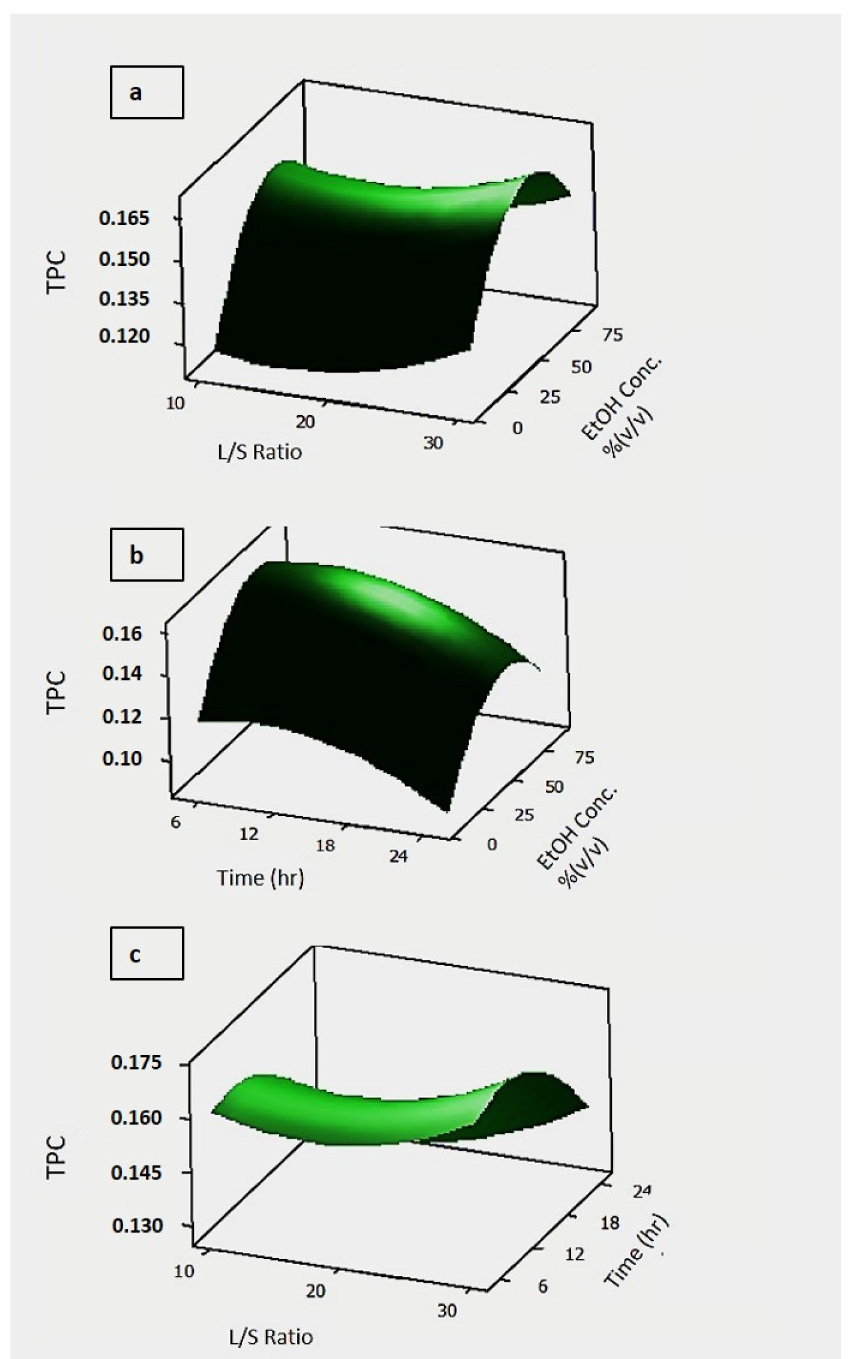
Figure 8. Effect of process parameters on the total phenol content. In the figure, ( a ) total phenolic content vs EtOH concentration and L/S Ratio; ( b ) total phenolic content vs time and EtOH concentra- tion; ( c ) total phenolic content vs L/S ratio and time. The hold values are set for treatment time 15 h, ethanol concentration 50%, and L/S ratio 20. The unit for total phenolic content is mg GAE (gallic acid